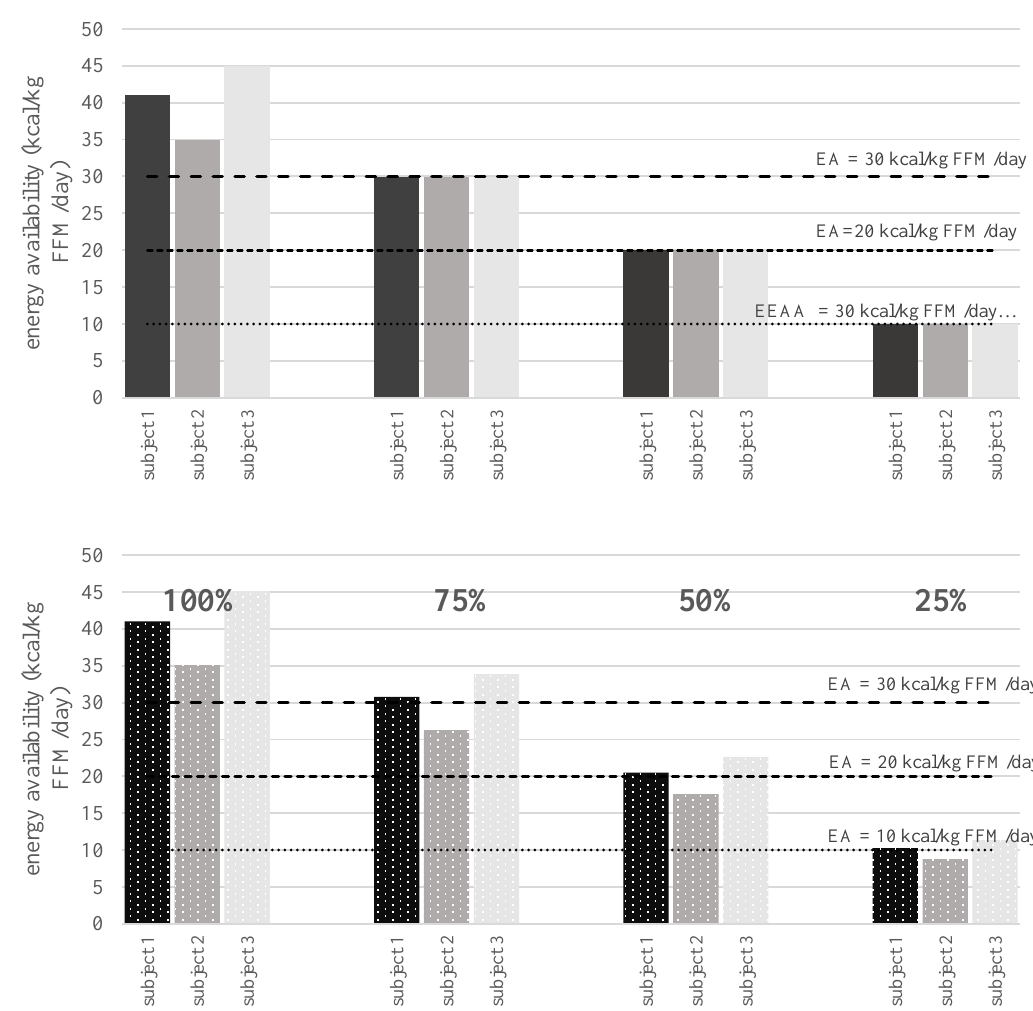
Figure 3. The difference in lowering EA to an absolute threshold value (30, 20 and 10 kcal/kg FFM/day) or relative to baseline values (75%, 50% and 25%) in a more individualized manner on 3 representative subjects.